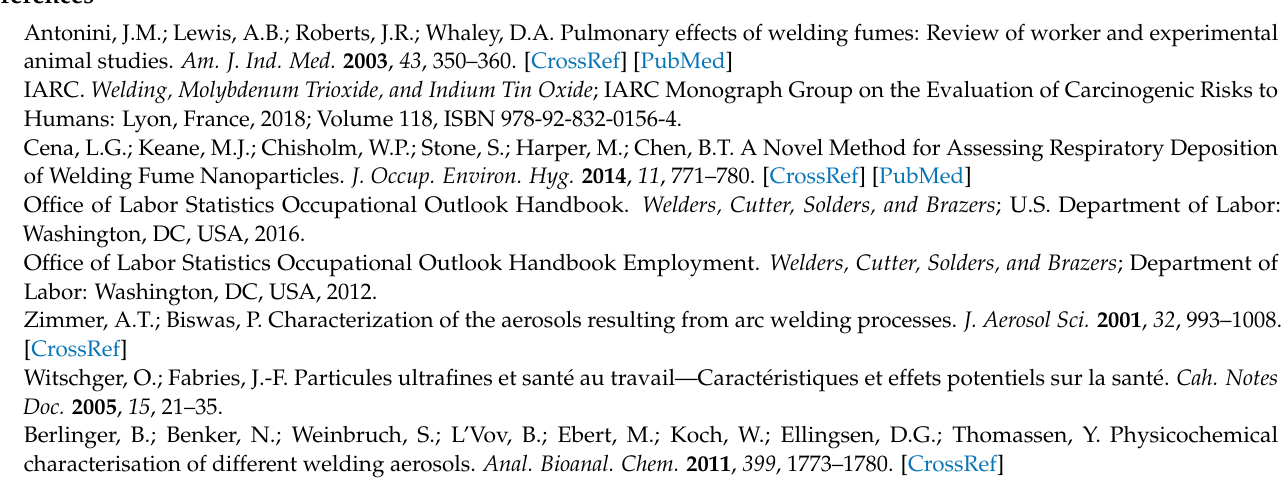
Figure A3. Blank-corrected rates of DTT loss as a function of the concentration of soluble metal for six DTT-reactive transition metals: each point represents the average ( ± σ ) of multiple individual rate determinations. Circular points represent experimental OP measurement. Lines represent regression fits to the experimental data; the corresponding equations are listed in Table 2 of the manuscript. The red graduated lines denote the methodological detection limit (MDL), and the blue ones denote the methodological quantification limit (MQL) (defined in the Section 2.7 of the manuscript). SSWF-1 refers to stainless steel welding fume and MSWF-1 refers to mild steel welding fume PB-soluble